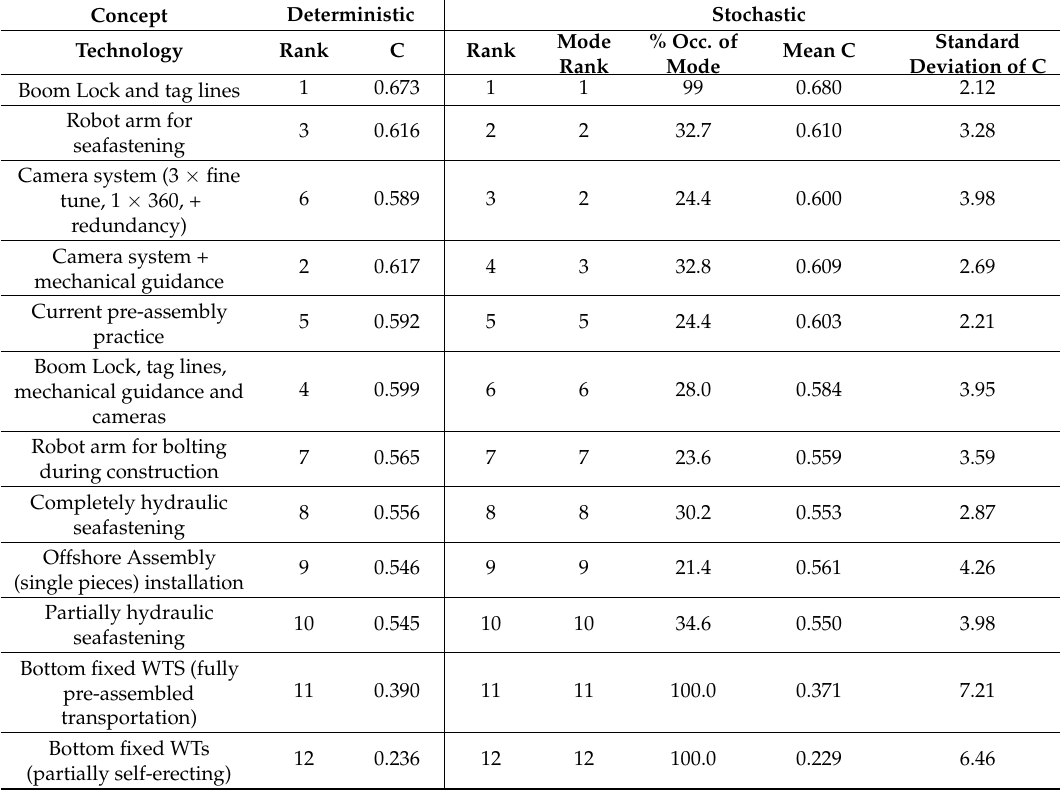
Table 10. Final ranking of all proposed